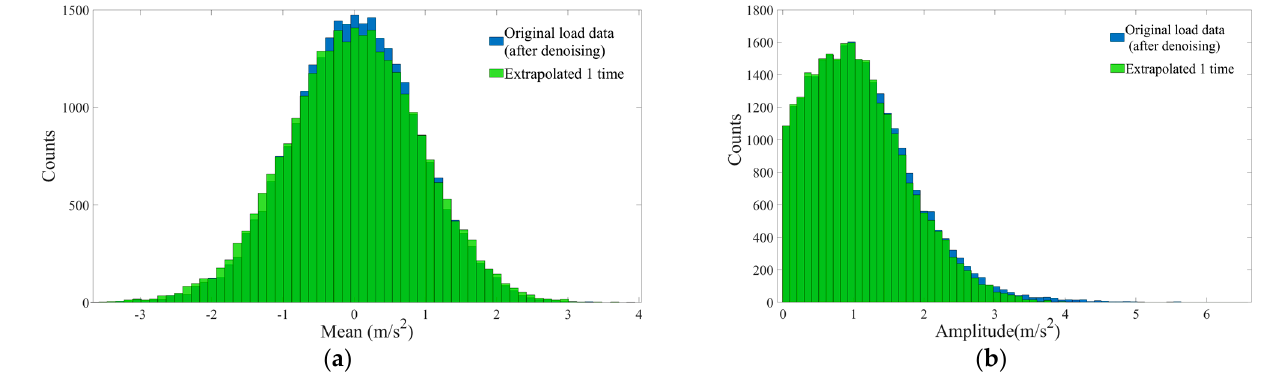
Figure 17. Comparison of Mean and Amplitude counts of original load and extrapolated 1-time load data: (a) mean counts histogram; (b) amplitude counts histogram.